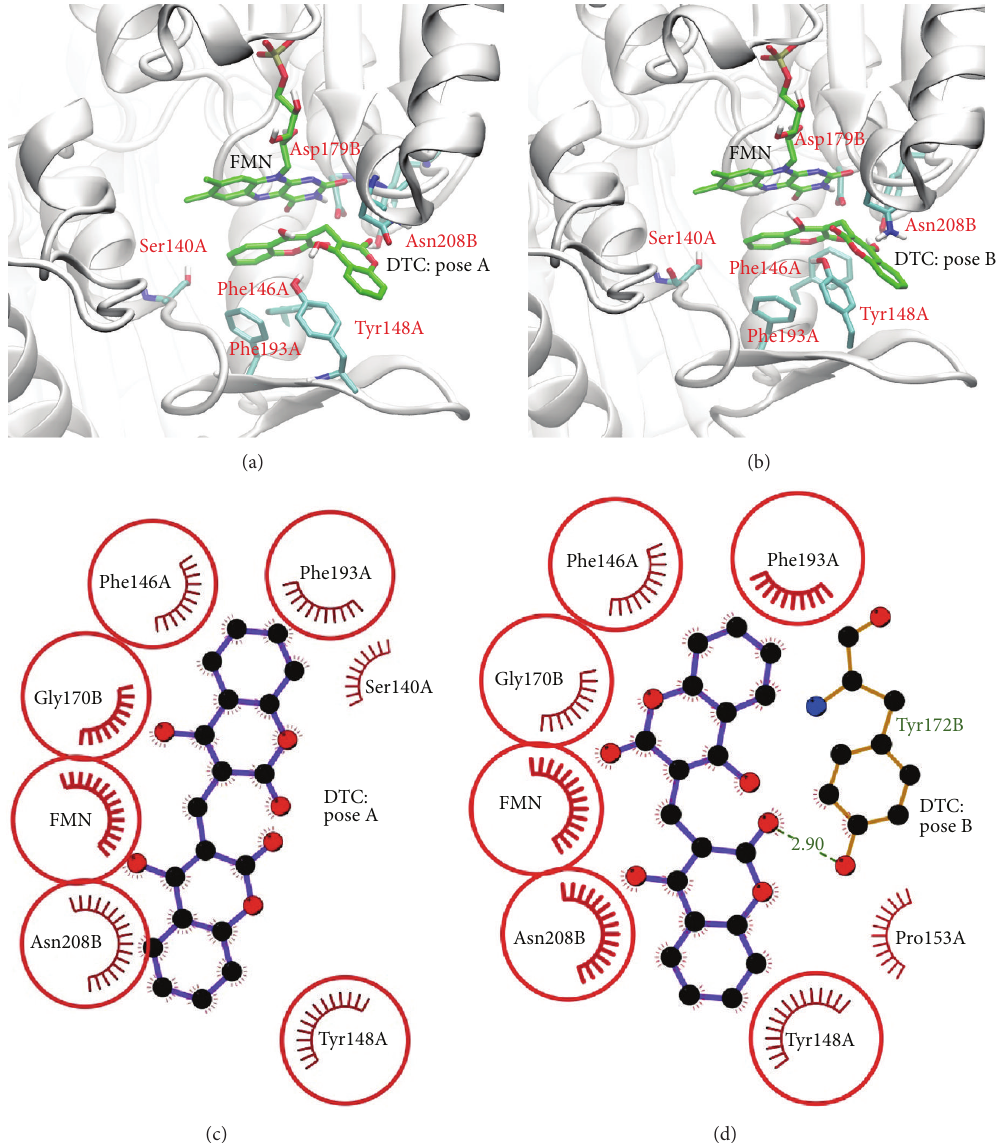
Figure 4: Docked orientations and interactions of dicoumarol in the enzyme binding sites. (a) and (b) compare the ligand poses A and poses B, respectively. The surrounding conserved residues, FMN, and dicoumarol molecules are in stick representation. (c) and (d) are schematic 2D diagrams of protein-ligand binding poses A and B, respectively. Spoked arcs represent residues making hydrophobic contacts with the ligand, whereas dashed lines represent hydrogen bonds between the atoms involved. The 2D representation was created using the program LigPlot